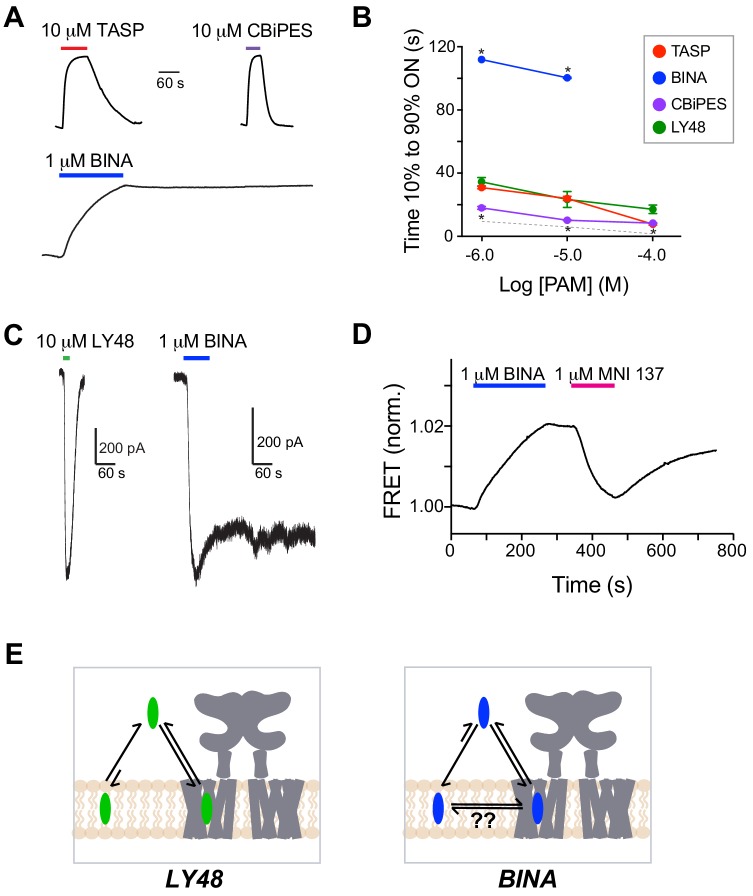
Different mGluR2 PAMs alter inter-TMD FRET and receptor activation with distinct kinetics and reversibility.(A) Representative inter-TMD FRET traces for TASP, CBiPES and BINA showing slower onset and lack of reversibility for BINA. (B) Summary of dose-dependent ON kinetics for all four mGluR2 PAMs tested BINA was significantly slower (unpaired T-test; 1 μM: p=0.000002, 10 μM: p=0.007) and CBiPES was significantly faster (unpaired T-test; 1 μM: p=0.04, 10 μM: p=0.03, 100 μM: p=0.02) than LY48. At least three separate measurements were made for each condition. Error bars show s.e.m. The dotted gray line shows the values obtained for glutamate in the inter-LBD FRET response. (C) Whole cell patch clamp recordings showing reversibility of LY48 agonism and irreversibility of BINA agonism of full-length mGluR2. (D) Representative inter-TMD FRET trace showing the effect of application of an mGluR2 NAM (MNI 137) following BINA application. Notably, MNI 137 reverses the BINA-induced FRET increase but following MNI 137 washout, the FRET level increases again. (E) Schematics showing working model of PAM binding and membrane interaction for LY48 versus BINA. Unlike other PAMs, BINA may partition directly into the lipid bilayer from where it can access the allosteric binding site on mGluR2 either directly within the bilayer or following exit on the extracellular side.